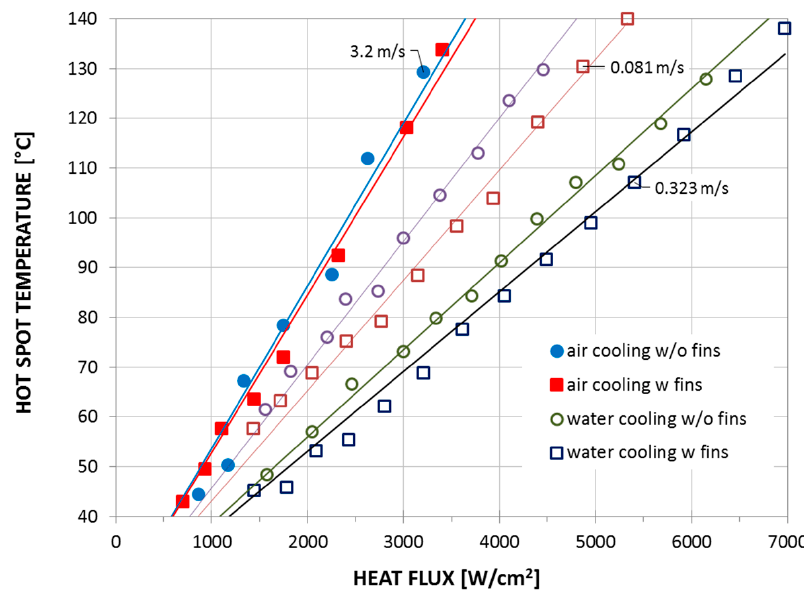
Figure 5. Cooling performance of the CNT-based micro heat sink using water as coolant (with air cooling as a reference) plotted as the hotspot temperature vs. heat flux. Experimental data sourced from Reference [22].